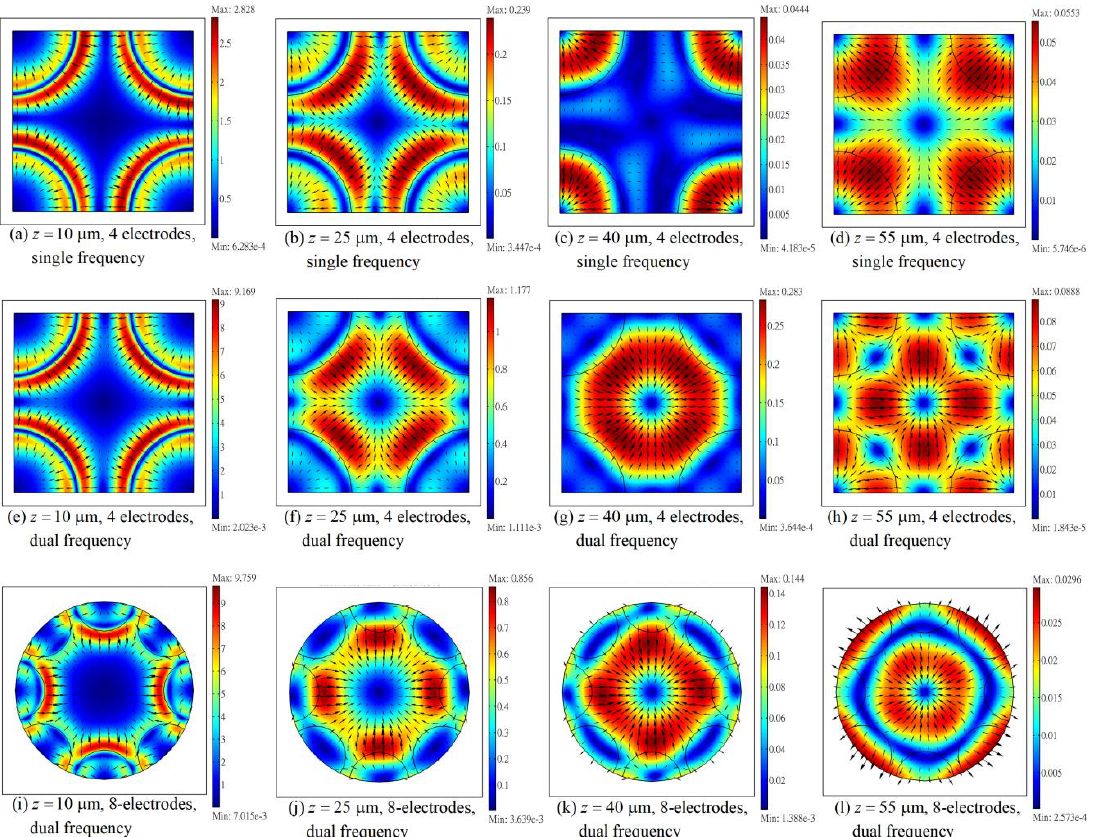
Figure 4. Distributions of the dimensionless horizontal trapping force ( (cid:101) F th ) on horizontal planes at different heights for the negative DEP case in Figure 2. ( a–d ), ( e–h ) and ( i–l ) are the cases for the four-electrode system with single frequency operation, the four-electrode system with dual frequency operation, and the eight-electrode system with dual frequency operation, respectively. Graphic notations are the same as those in Figure 2.